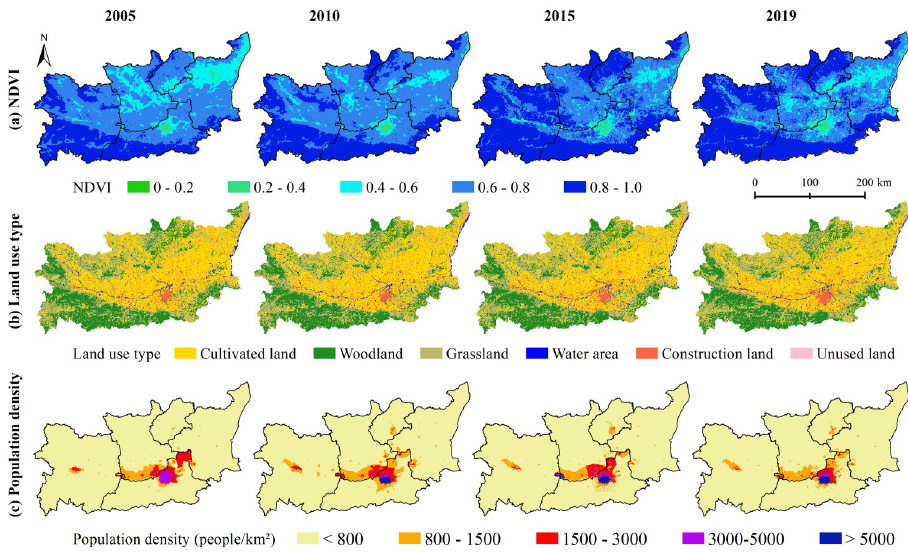
Fig 8. Spatial distribution map of NDVI, land use type and Population density in 2005, 2010, 2015 and 2019. https://www.resdc.cn/Datalist1.aspx?FieldTyepID=20,0.